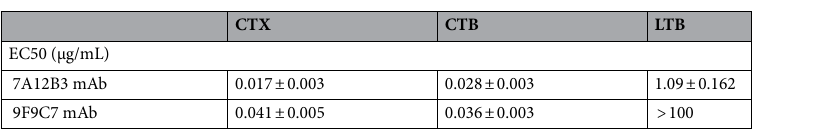
Table 1. Average EC 50 values and standard deviation (N = 2) of 7A12B3 and 9F9C7 mAbs binding to CTX, CTB and